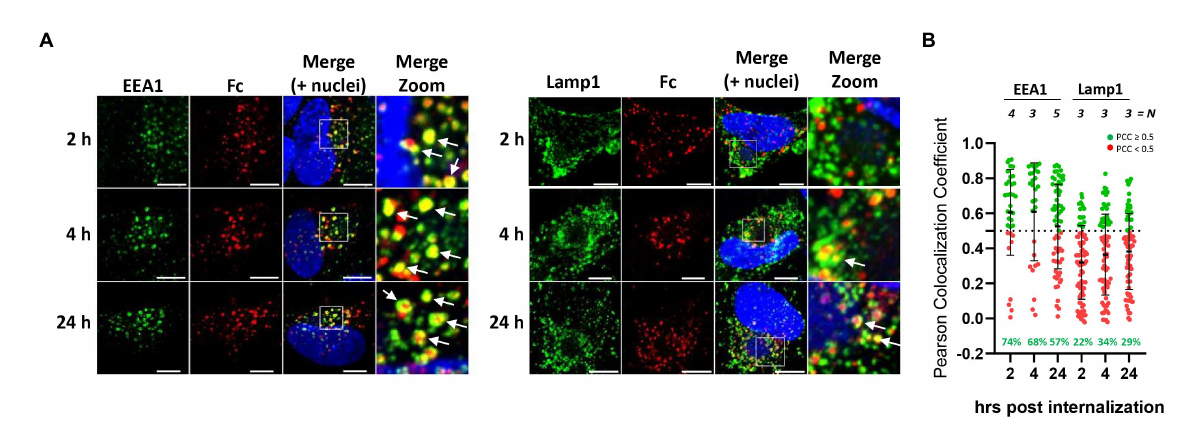
FIGURE 2 Endocytosed human Fc fragment is retained in the early endosomes. (A) HFF-1 were infected with HCMV TR strain. Five d.p.i. cells were incubated with 647 DyLight conjugated human IgG Fc fragment on ice for 60 min before being washed and shifted to 37°C to allow for internalization. At the indicated time points, cells were fixed and stained with antibodies against early endosomes and/or lysosomes (green color, EEA1 and Lamp1, respectively). Images were collected through confocal microscopy. Z-stack projection of representative pictures is shown. Superimposition of signals from human Fc (Fc, red color), cellular markers are shown in the merge panels. Scale bar: 5 μ m. White arrows indicate signals overlapping. (B) Quantification of data from (A) . Z-stacks have been deconvolved and Fc-positive objects have been segmented. For each of them, Pearson’s colocalization coefficients (PCC) between Fc signal and endosomes (EEA1) or lysosomes (Lamp1) was calculated. Each dot corresponds to an Fc-positive object. N = number of cells analyzed for each condition. Numbers in green represent the percentage of Fc-positive vesicles colocalizing with the respective cellular marker (Pearson’s coefficient ≥